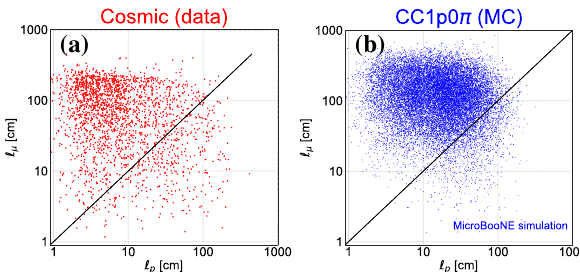
Fig. 5 The distributions of the segmented length of the track labeled as the muon candidate, l μ , vs. the track labeled as the proton candidate, l p , after the application of the cuts on dE / dx and matched PMT flash in MicroBooNE in: a cosmic data, and b simulated CC1 p 0 π events